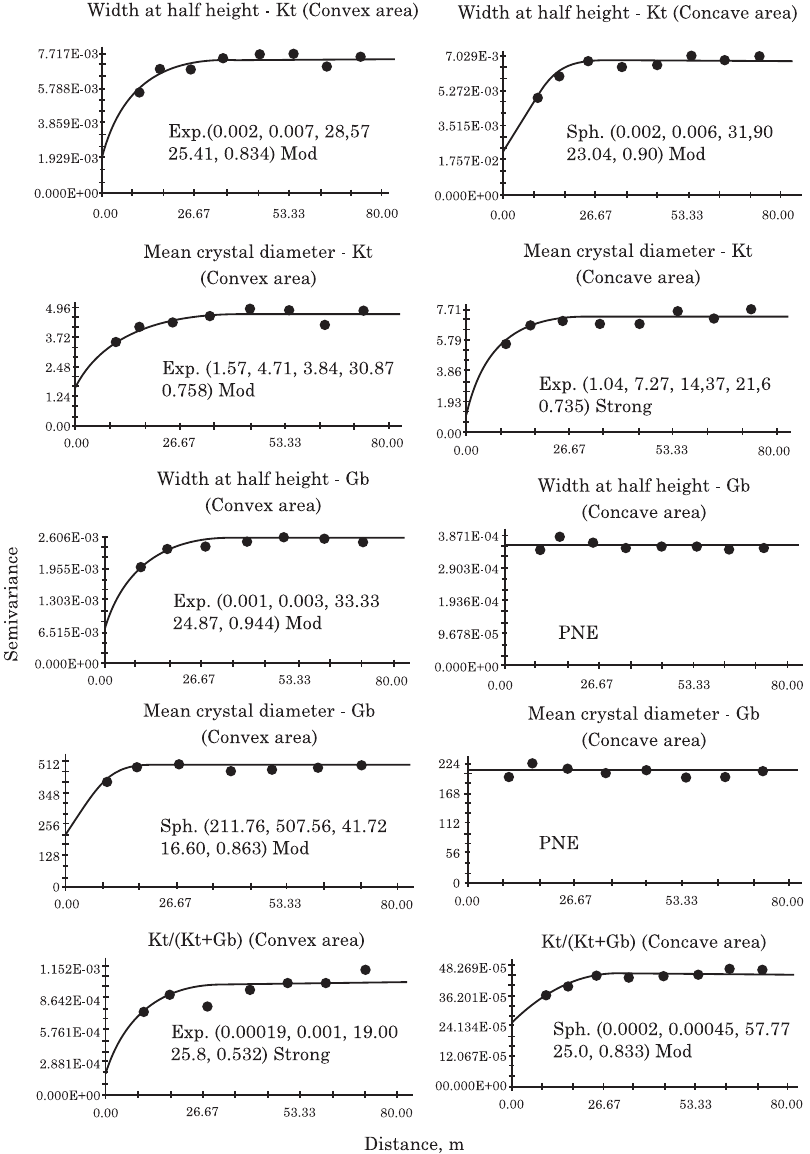
Figure 4. Semivariograms of the studied attributes in the convex and concave areas. Kt: kaolinite, Gb: gibbsite, PNE: Pure nugget effect, Sph.: Spherical, Exp.: Exponential, Mod: Moderate. Sequence of the semivariogram parameters: C o ; C 1 ; C o / (C o + C 1 ) (%); range; r 2